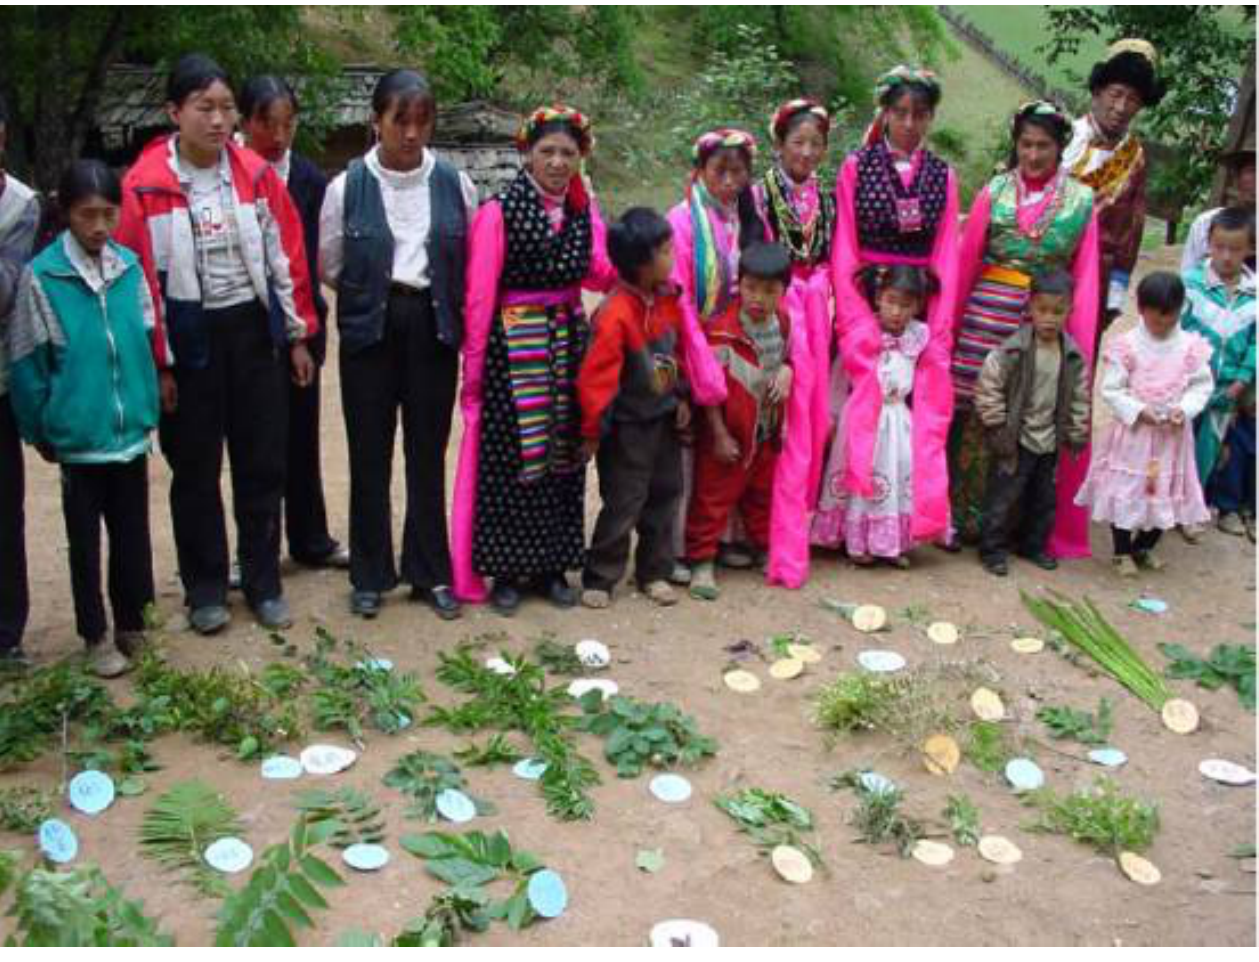
Fig. 1. In 1 h, Tibetan villagers in northwest Yunnan collected more than 80 species of local plants used as medicines, food, fiber, etc. These have been used for generations and are classified within the village's epistemological and knowledge